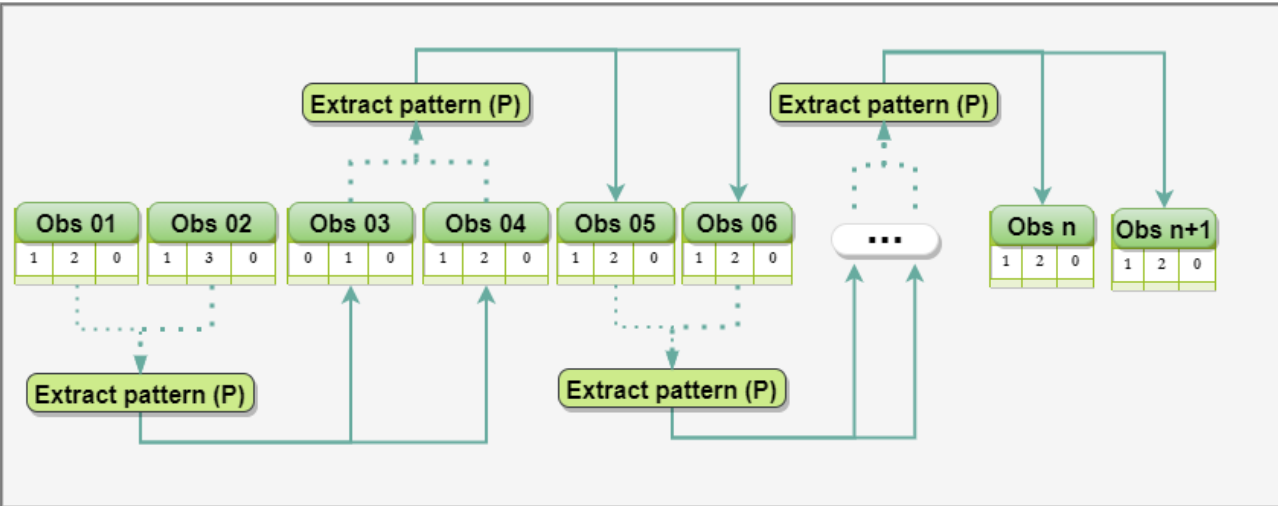
Figure 9. Evaluation of the prediction performance of sociability patterns using two